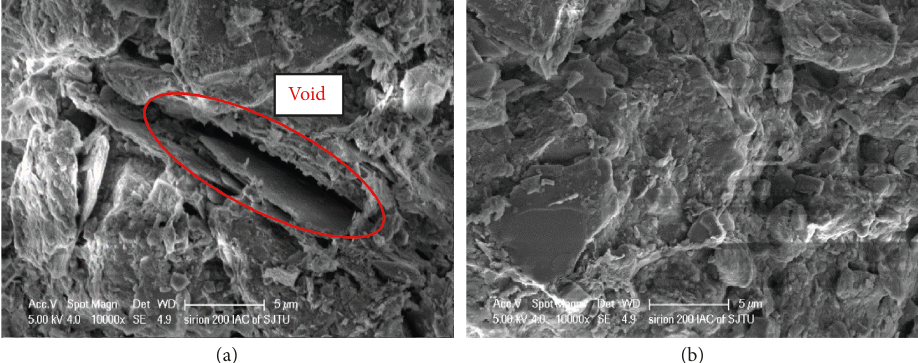
Figure 9: SEM images of the specimen samples under magnification of 1000: (a) without CMC; (b) with 1.0%